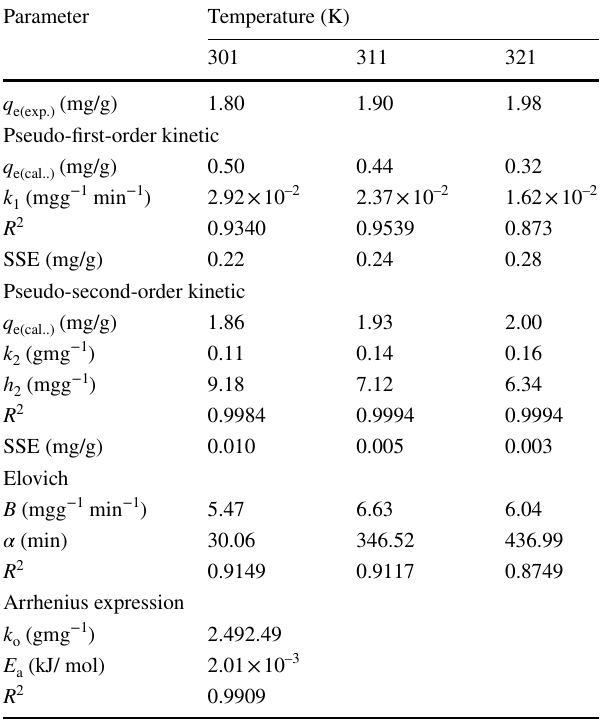
Table 3 Kinetic parameters for adsorption of CR dye on MSC at